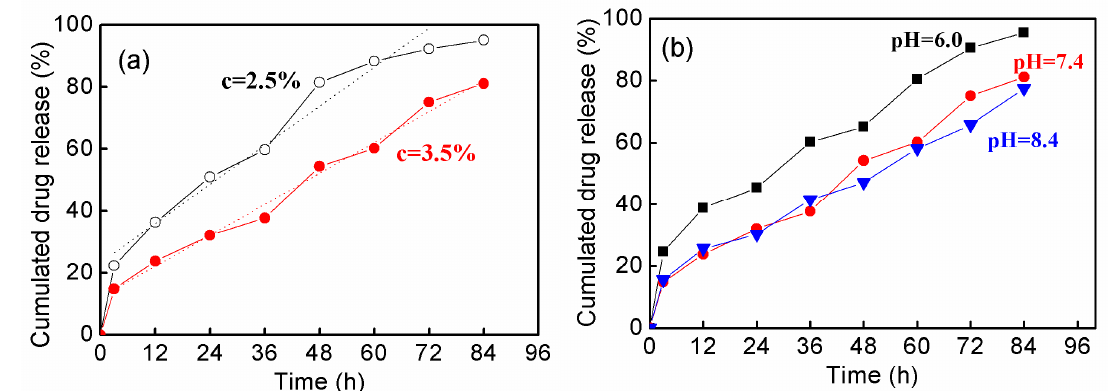
Figure 8. The drug release profiles from the hydrogels fabricated by P(AA- co -VAm) microgels. ( a ) Drug released from P(AA- co -VAm) microgels with 2.5% and 3.5% polymer concentration at pH 7.4. The dotted lines were the linear fitting results. ( b ) Drug released from P(AA- co -VAm) microgels with 3.5% polymer concentration at different pH levels.